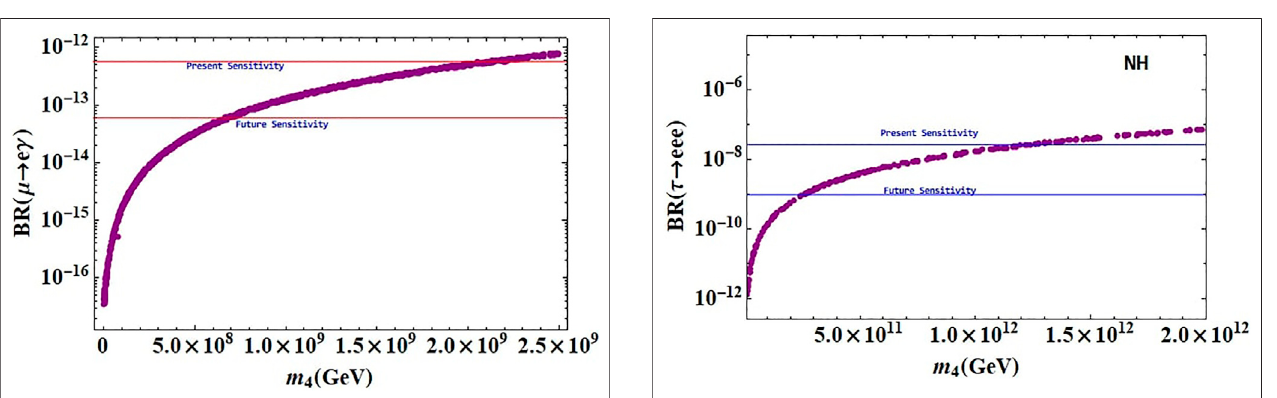
FIGURE 11 | BR ( τ − eee ) as a function of the sterile neutrino mass. The blue horizontal line represents the experimental bounds on this process.